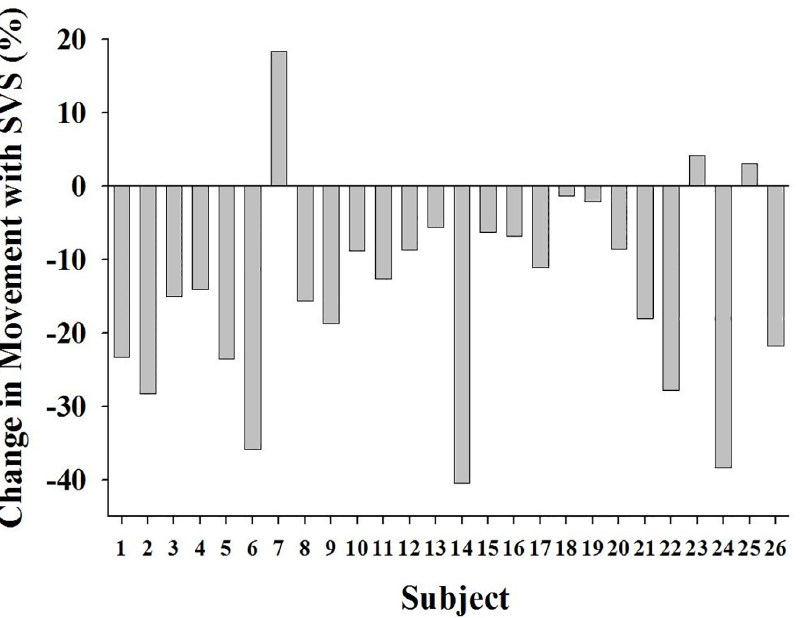
Fig 3. Change in movement with SVS among subjects. SVS reducedmovement durationin 23 of the 26